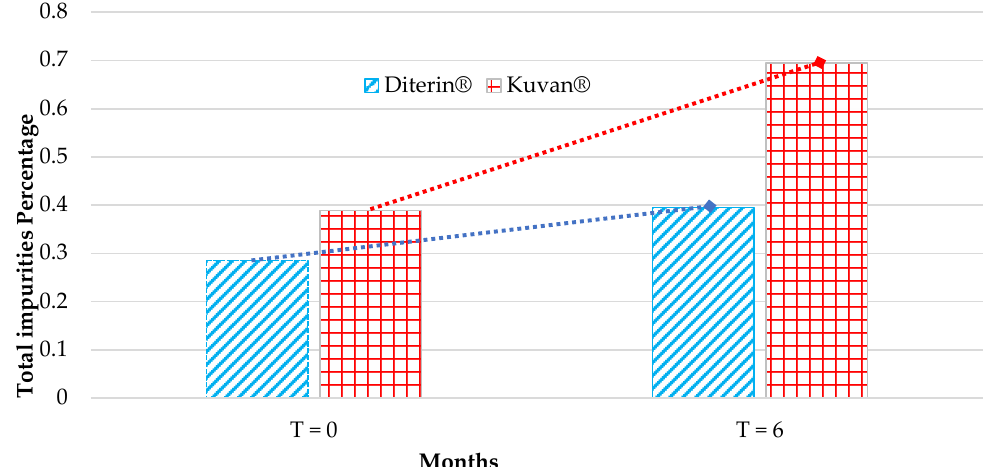
Figure 3. Trend of total impurities concentration (Table 2) for Kuvan ® and Diterin ® at T = 0 and after 6 months at 40 °C and 75% RH (accelerated stability study) .